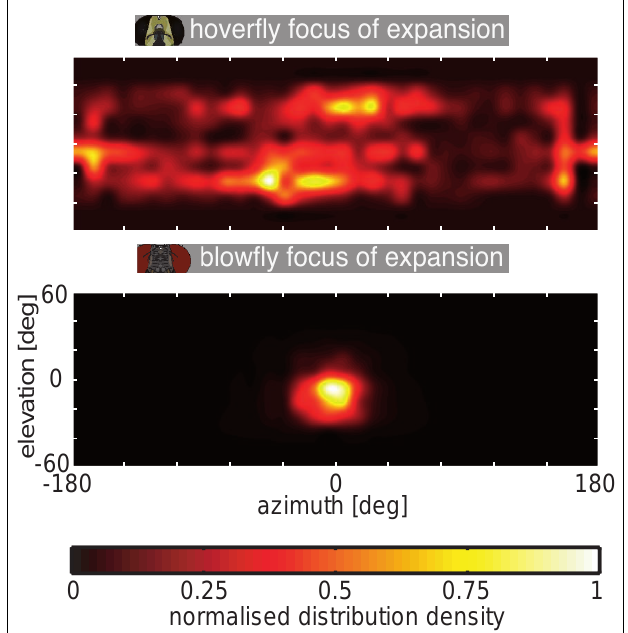
FIGUREA1 | Distribution of the focus of expansion. The location of the focus of expansion within the visual field was calculated from the optic flow corresponding to the head trajectories and plotted as color coded density distribution; top: hoverfly, bottom: blowfly.The data were interpolated to avoid hard edges of the sample point grid (grid as in Figure 3 ).The density was normalized to the highest count inside the sample point grid separately for each